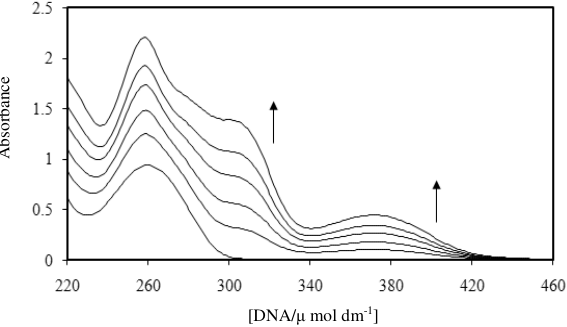
Figure 4 . Absorption spectra of DNA in the presence of MTX in different concentrations. = 0.0, 10.0, 20.0, 30.0, 40.0 and 50.0 µ mol L -1 for curves 1-6 and C c MTX in phosphate buffer (0.1 mol L -1 , pH 7.4) plus NaCl (0.1 mol L -1